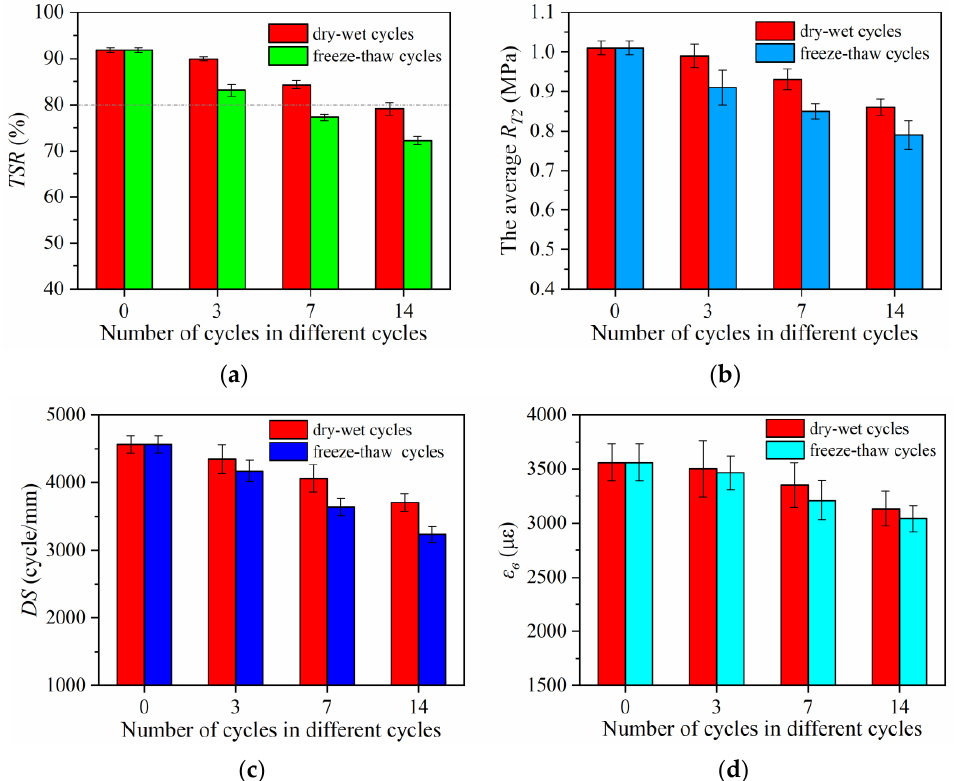
Figure 10. Long-term pavement performance test results under varying numbers of cycles: ( a ) freeze–